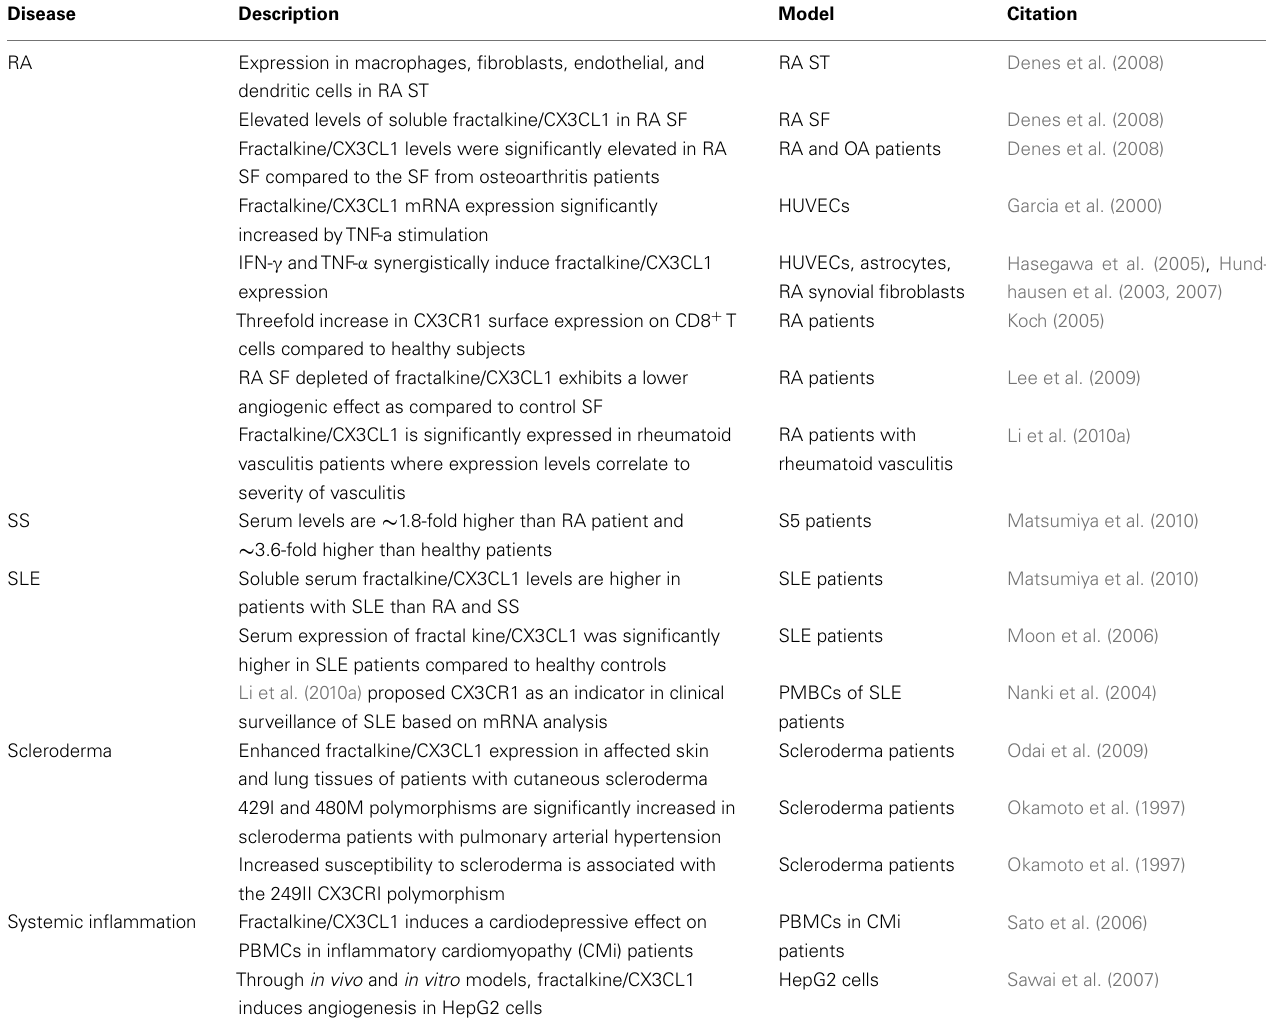
Table 1 | Summary of some basic and clinical human studies on the role of fractalkine/CX3CL1 in rheumatic diseases.